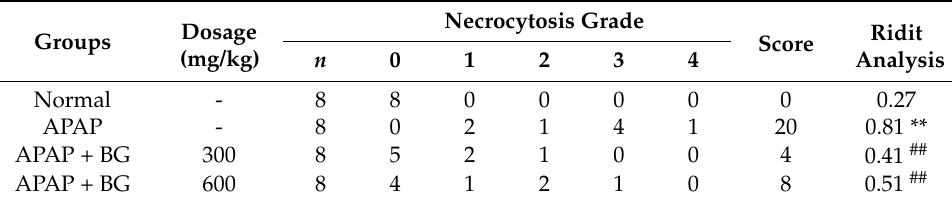
Table 2. Pathological changes in the liver and Ridit